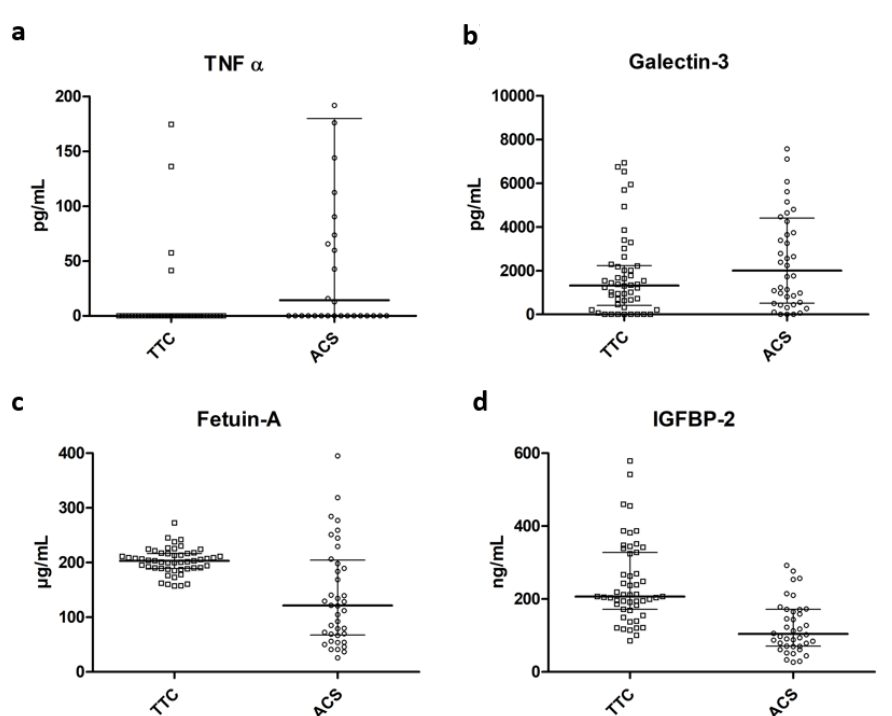
Figure 1. Comparison of biomarker levels between Takotsubo syndrome (TTC) and ACS patients. ( a ) TNF α . ( b ) Galectin-3. ( c ) Fetuin-A. ( d ) IGFBP-2. Table 2. Bivariate correlation and point-biserial correlation analysis of baseline characteristics and